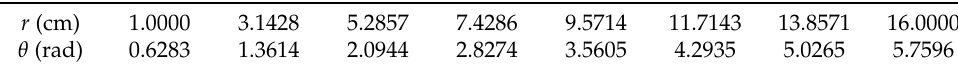
Table 3. Grid of 8 × 8 points in space used for training.